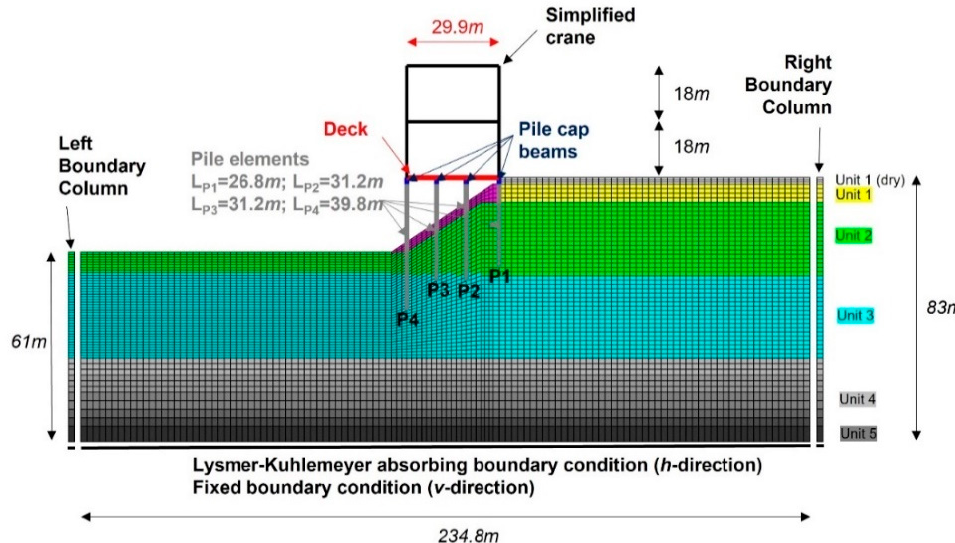
Figure 4. Numerical model built for a strategic infrastructure at Gioia Tauro port, composed of a pile ‐ supported wharf, a crane, and the surrounding soil deposits.